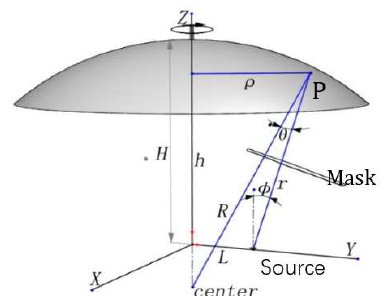
Figure 22. Rotating spherical substrate holder with mask, where H is the distance between the source and the top of the substrate holder; h is the height of the sample to the source position; Φ is the angle between the normal of the source and the line connecting the source to the P point; θ is the angle between the normal of the substrate and the line connecting the source to the P point; ρ is the distance from the center of the substrate holder to the P point; r is the distance from the source to the P point; L is the distance from the source to the center; P is any point on the substrate holder; R is the diameter of the spherical dome.